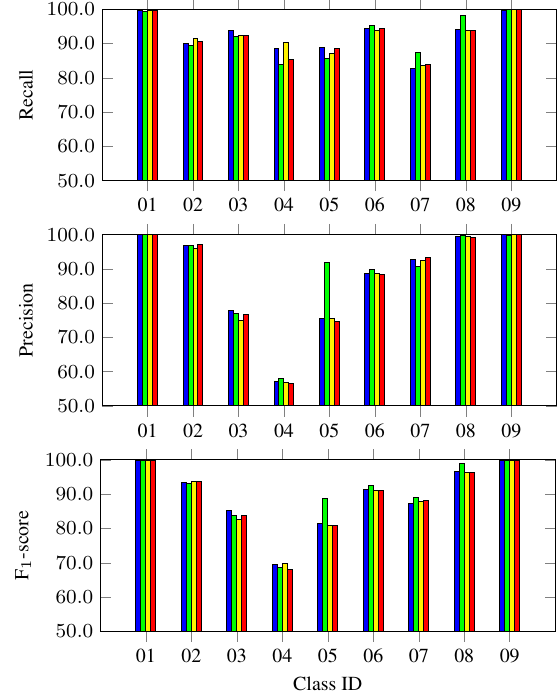
Figure 6. Recall (top), precision (center) and F 1 -score (bottom) (in %) achieved for the Pavia Centre dataset when using different data representations as input to a Random Forest classifier.